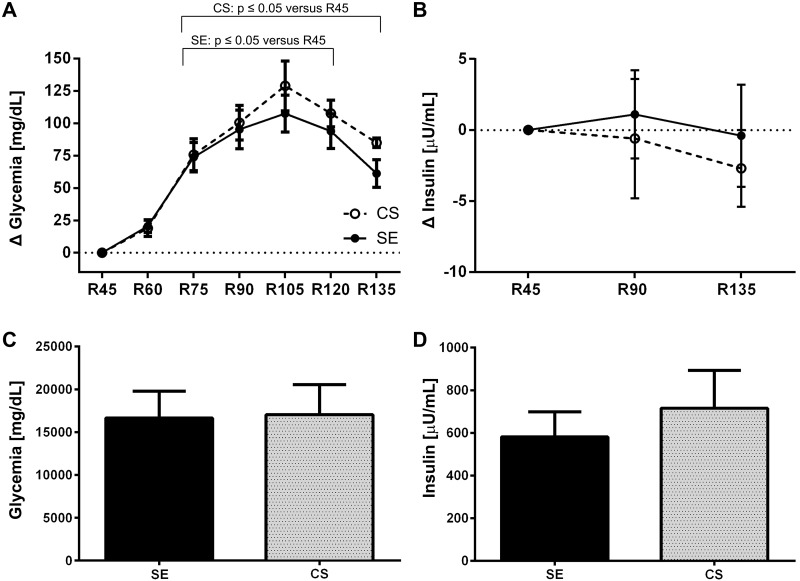
Glycemia (A) and insulin (B) kinects after dextrose ingestion by individuals with type 2 diabetes following 45 min of post-exercise recovery. The legend for panels A and B is provided in the bottom right corner of panel A. Total area under the curve for of glycemia (C) and insulin levels (D) for the R45-R135 period. Abbreviations: SE, submaximal exercise at constant workload; CS, control session. No differences were observed between the SE and CS at any of the time points.